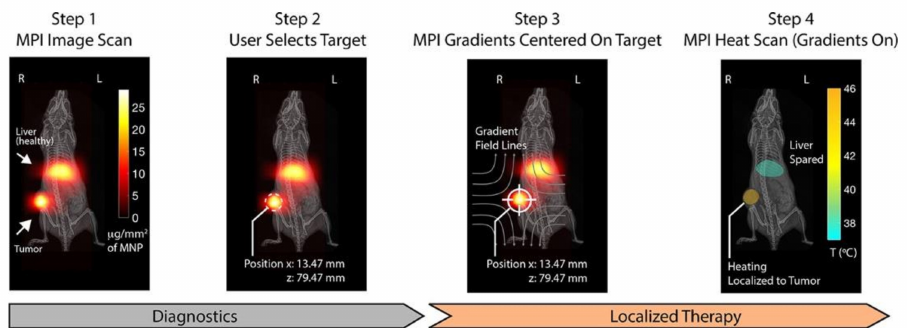
Figure 4. Theranostic workflow on a xenograft mouse model with SPIONs in its liver and tumor. Step 1: With an MPI scan at 20 kHz and 20 mT, the SPION present in the tumor and in healthy clearance organs (liver) can be seen clearly. The imaging parameters do not cause the SPIONs to generate heat. Step 2: The user selects a region, such as the tumor, to localize the magnetic hyperthermia. Step 3: The field free region (FFR) is located in the selected area by shifting the gradient field. This prevents the magnetically saturated SPIONs from generating heat. Step 4: A heat scan at 354 kHz and 13 mT is conducted with the MPI gradients held in position. Heating is experimentally restricted within the FFR while minimizing heat damage to the liver. Image reproduced, with permission, from Reference